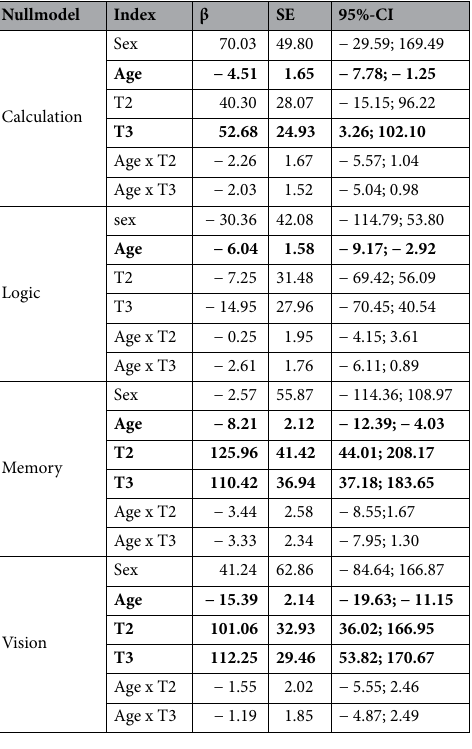
Table 3. Null models of the objective cognitive performance in tasks of calculation, logic, memory and vision. The following amount of influential data points were excluded for the analyses: Calculation: 1 influential